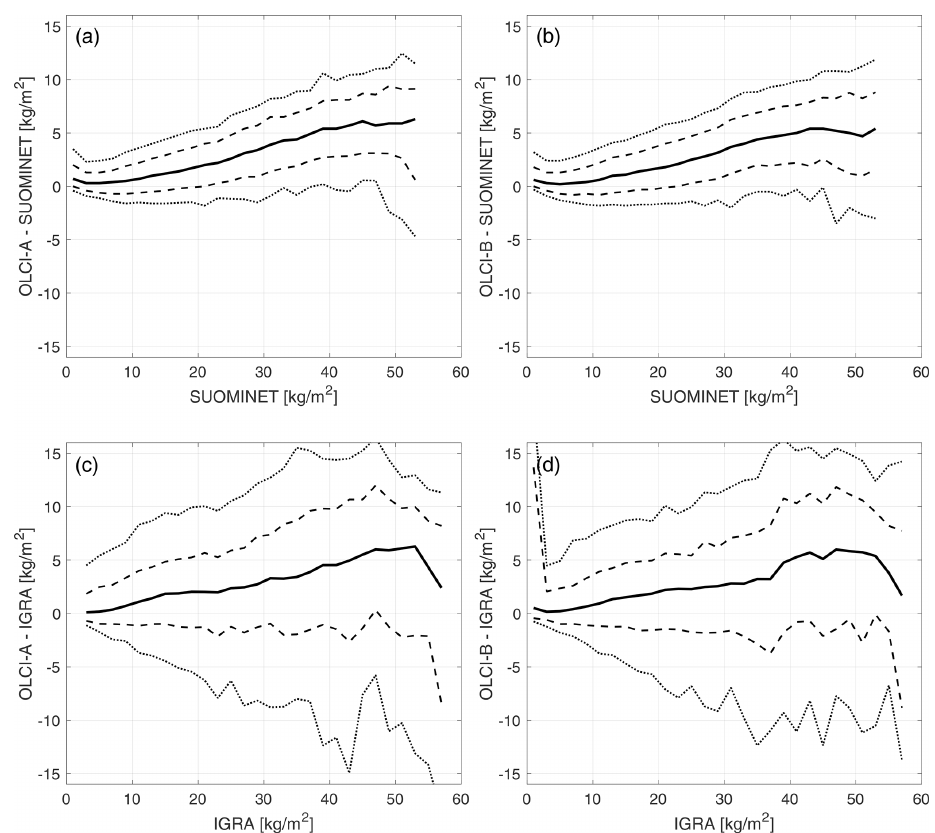
Figure 3. Difference OLCI of observations against SuomiNet (a, b) and IGRA (c, d) for OLCI-A (a, c) and OLCI-B (b, d) . The solid line shows the median of each 2kgm − 2 wide bin, while the dashed lines show the 16th and 84th percentiles and the dotted lines the 5th and 95th percentiles. Bins with fewer than 20 matchups were omitted from the